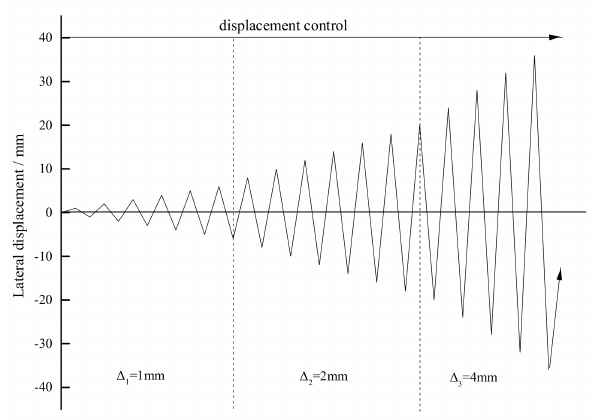
Figure 5. Loading